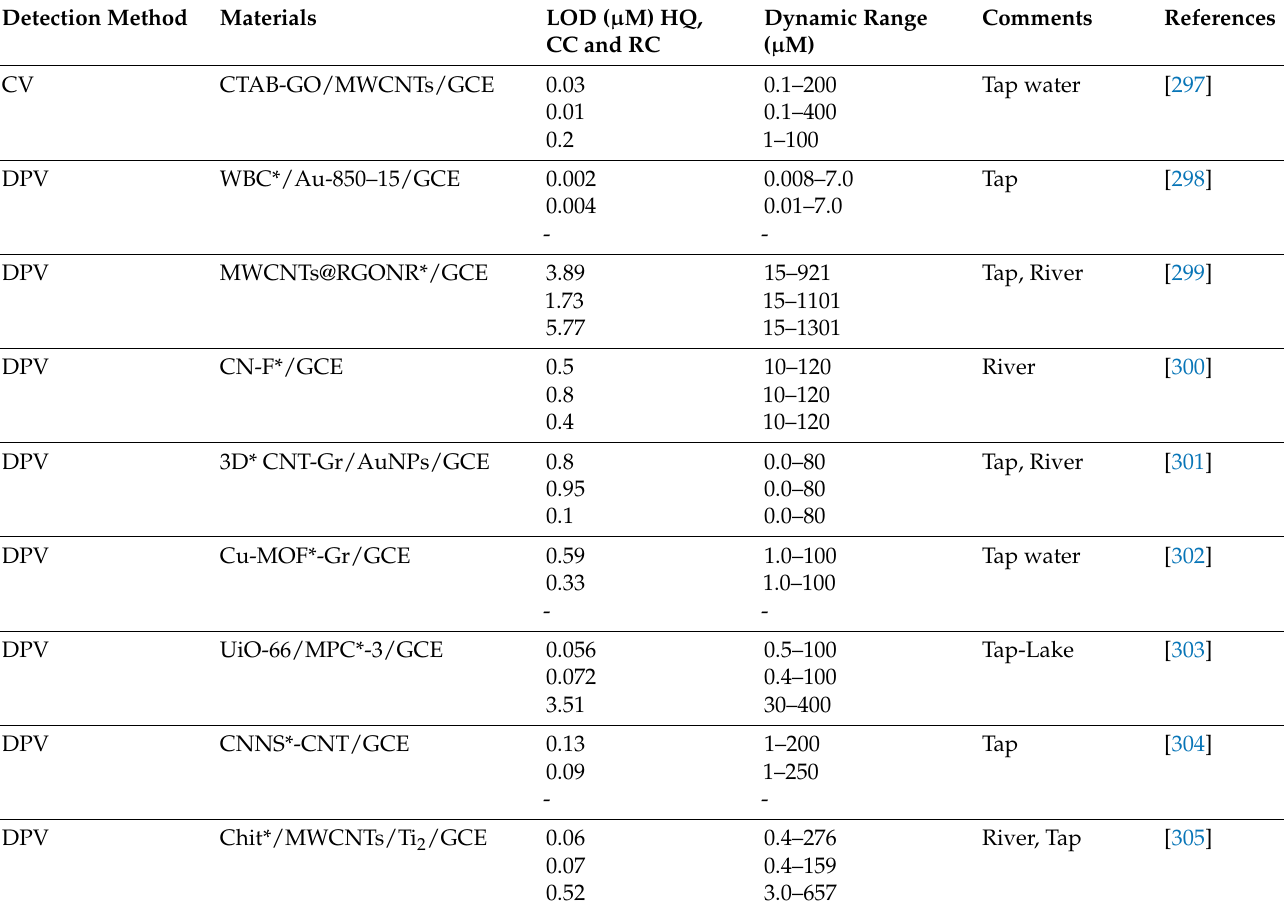
Table 9. Overview of electrochemical sensors for dihydroxybenzene isomers. Detection